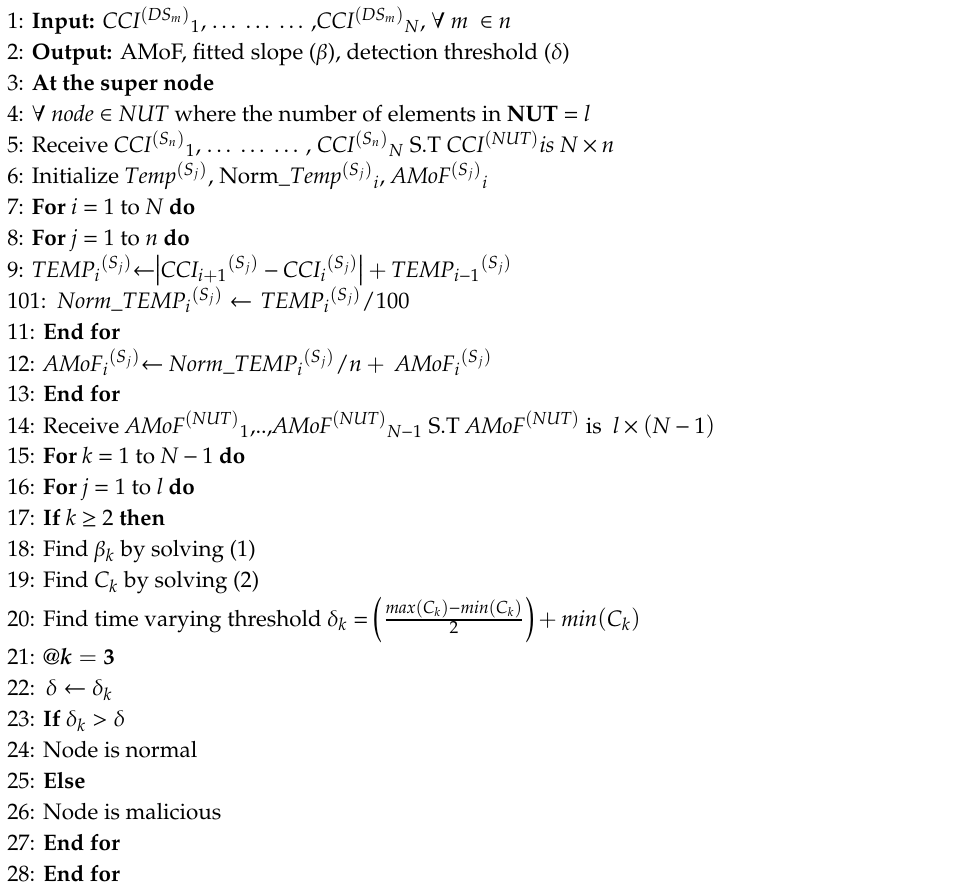
Algorithm 1 Calculating the AMoF, fitted slope, confidence intervals, and detection